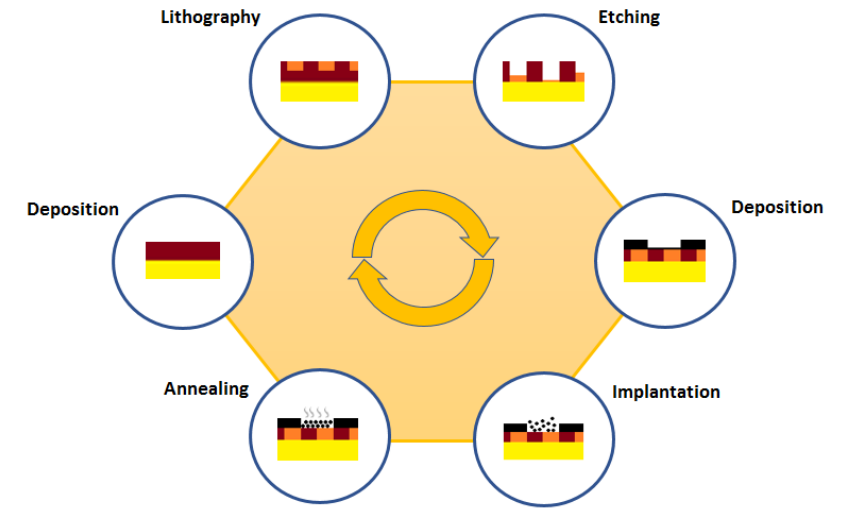
Figure 1. Semiconductor wafer manufacturing